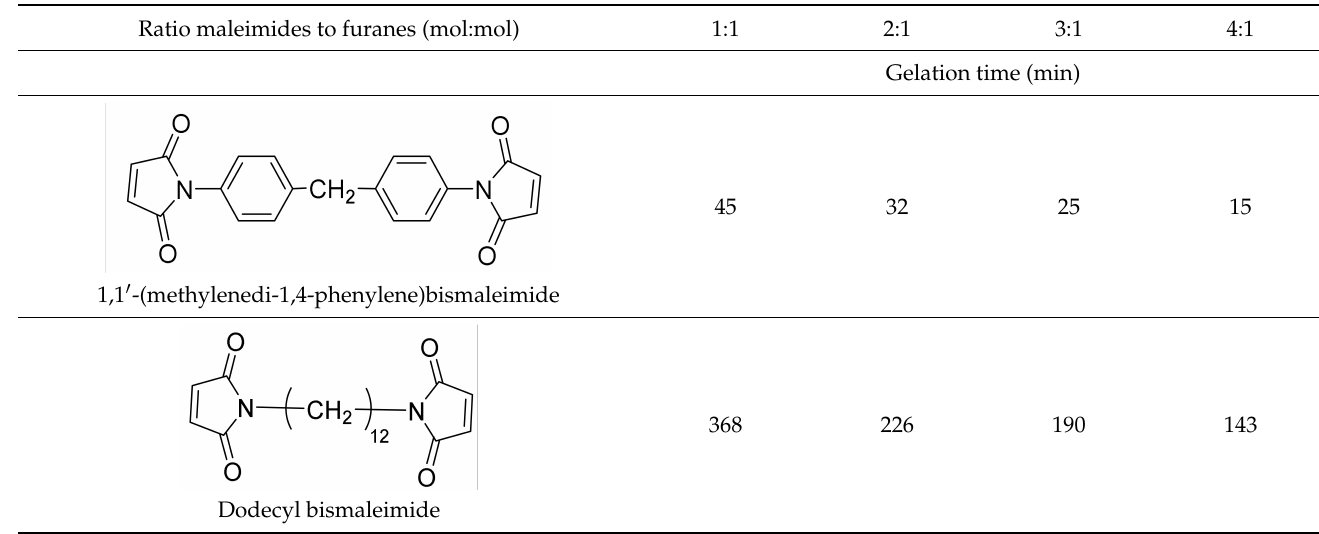
Table 1. Gelation times for various ratios of two different bismaleimides. Ratio maleimides to furanes